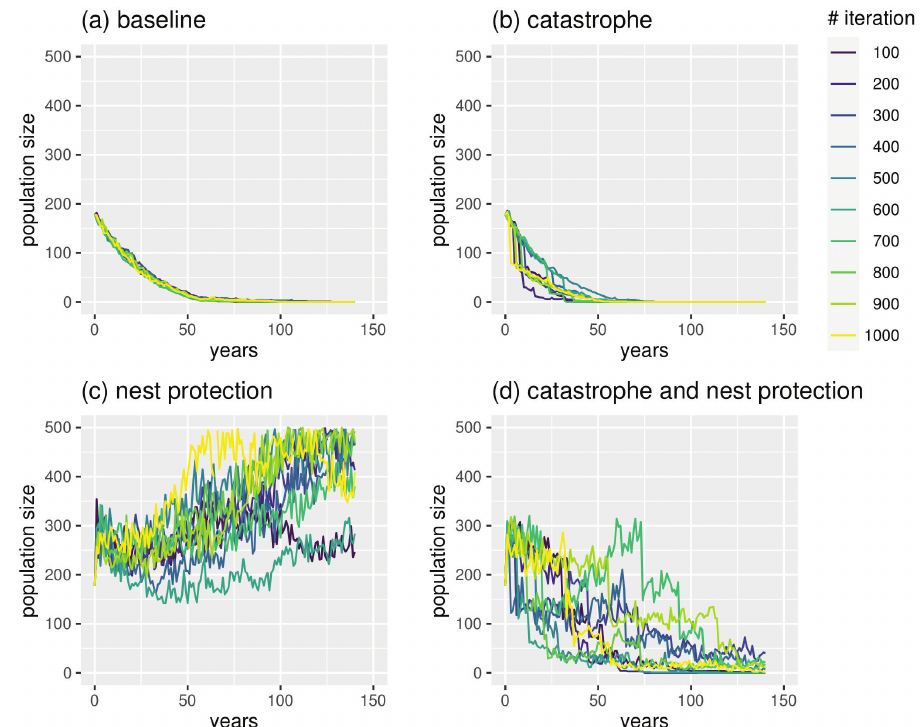
Figure 5. Fluctuation of selected (every hundredth) iterations of the simulated population viability